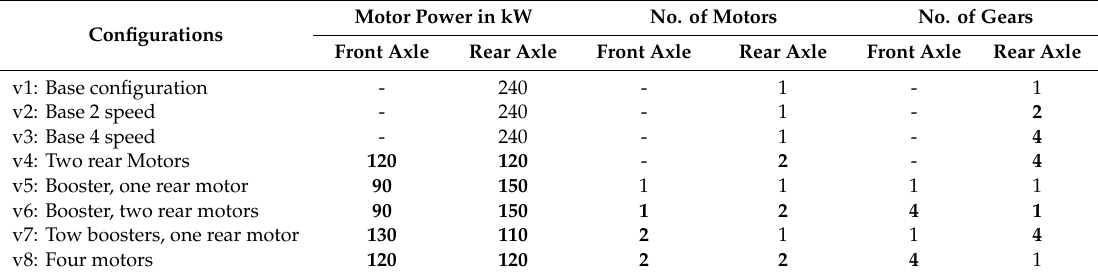
Table 3. Selected configurations for a detailed